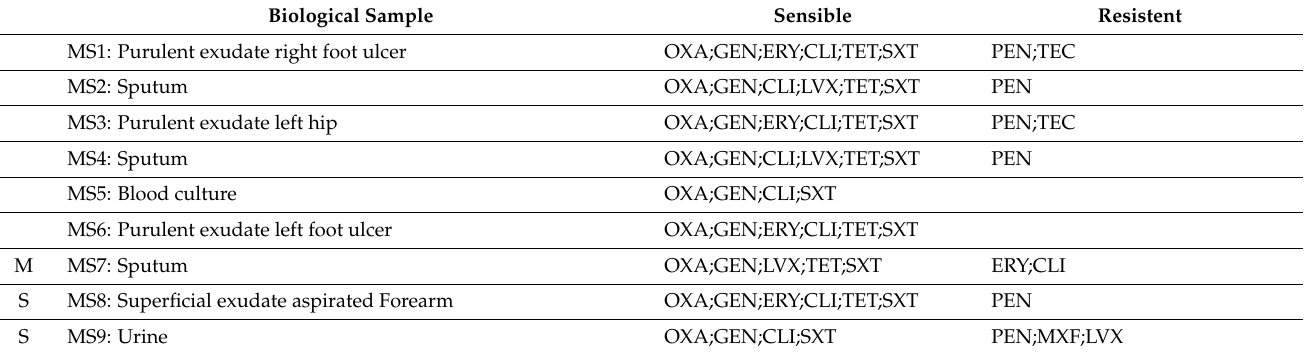
Table 3. Antibiotic susceptibility of MSSA (MS) and MRSA (MR) nosocomial isolated strains to OXA (Oxacillin); GEN (Gentamicin); ERY (Erythromycin); CLI (Clindamycin); TET (Tetracycline); SXT (Trimethoprim/Sulfamethoxazole); PEN (Penicillin); TEC (Teicoplanin); MXF (Moxifloxacin); LVX (Levofloxacin); FA (Fusidic Acid); and VAN (Vancomycin). Biological